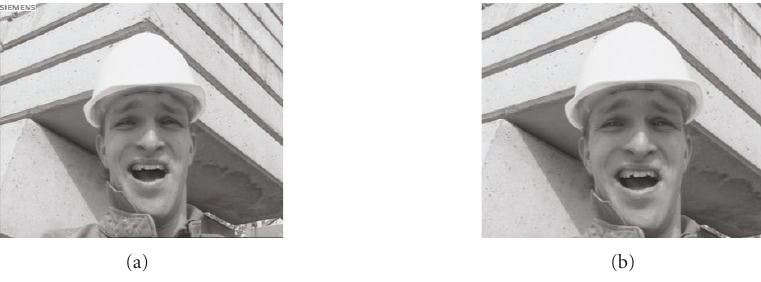
Figure 3: The 24th frame in the “Foreman” sequence. (a) The original 352 × 288 image and (b) the extracted 320 × 256